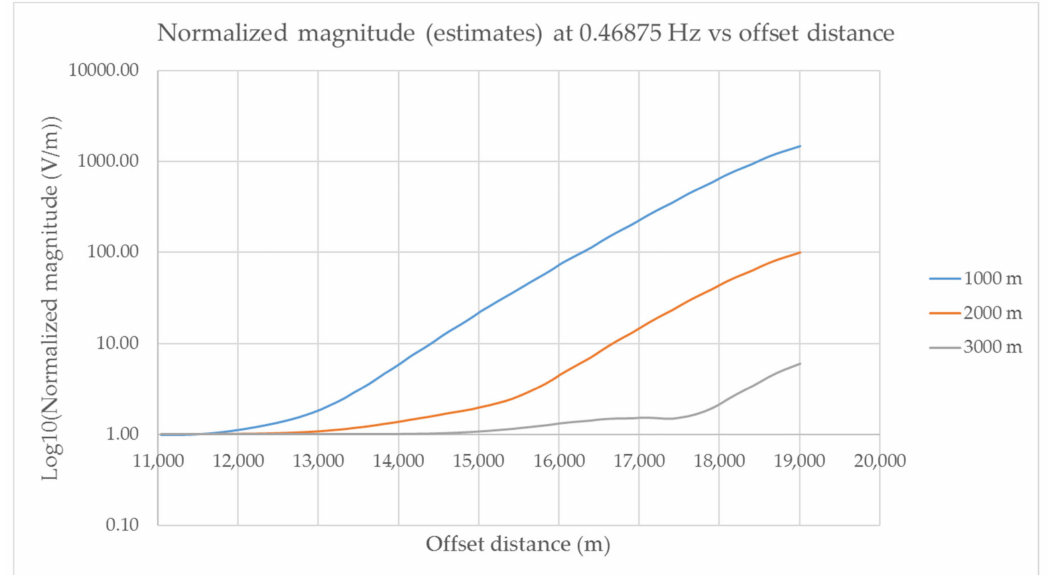
Figure 15. Normalized MVO responses for transmission frequency of 0.46875 Hz: (i) normalized MVO for a hydrocarbon depth of 1000 m (blue); (ii) normalized MVO for a hydrocarbon depth of 2000 m (reddish-yellow); (iii) normalized MVO for a hydrocarbon depth of 3000 m